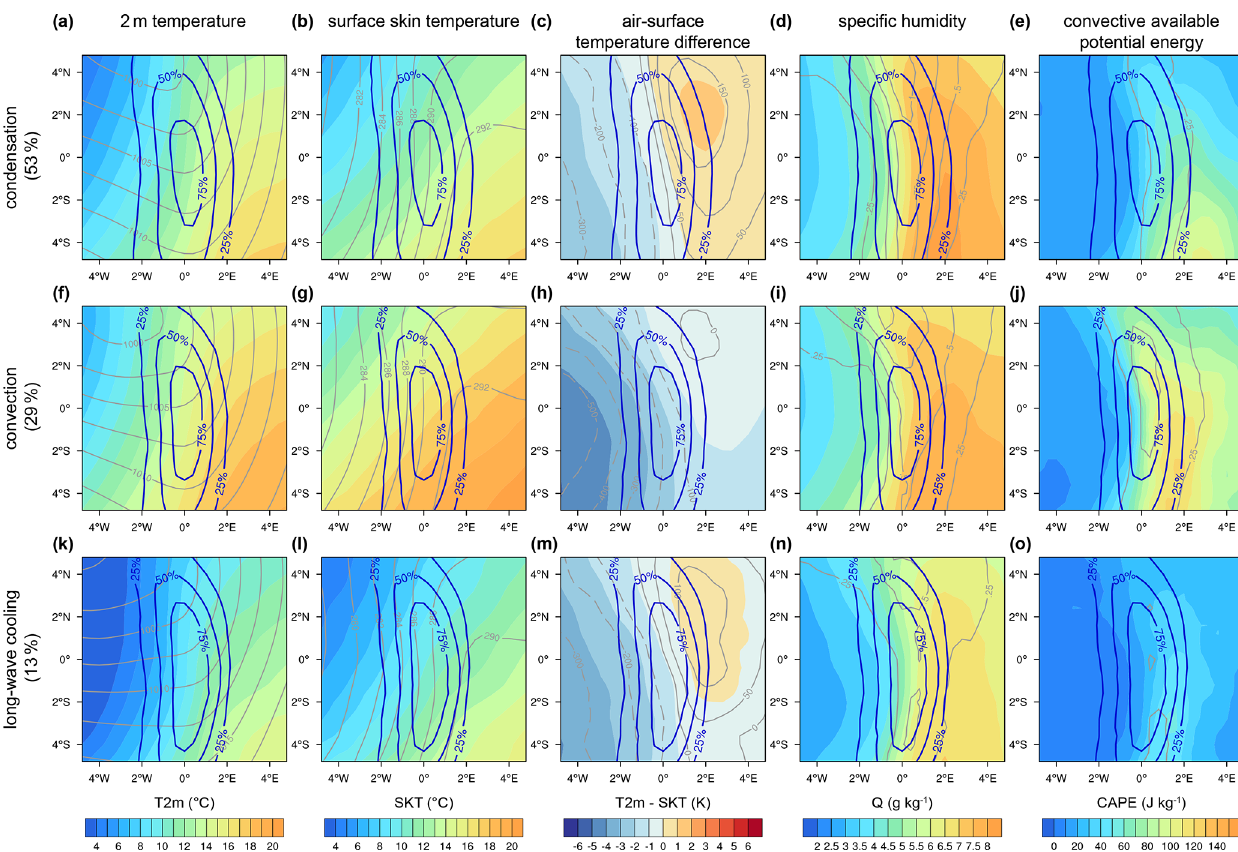
Figure 7. Composites of the environmental condition along the cold front averaged over the 24h period of most rapid cyclone intensification for subsets of the 144 extratropical cyclones of the cold season. Rows represent different cyclone categories based on the primary process that produces the positive PV anomaly along the cold front (Fig. 4a). Depicted are surface fields, except for specific humidity which is shown at 900hPa. Blue contours indicate average cold front frequency while gray contours show sea level pressure (a, f, k) , θ at 900hPa (b, g, l) , surface sensible heat flux (c, h, m) , large-scale precipitation (d, i, n) , and convective precipitation (e, j, o)